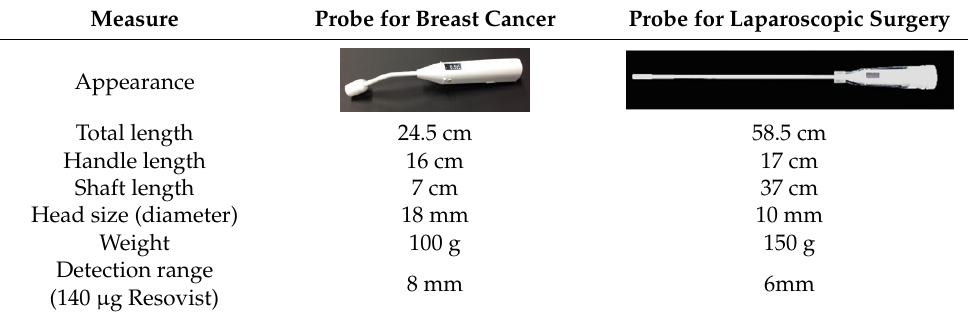
Table 1. Comparison of the probes for breast cancer and laparoscopic surgery. Measure